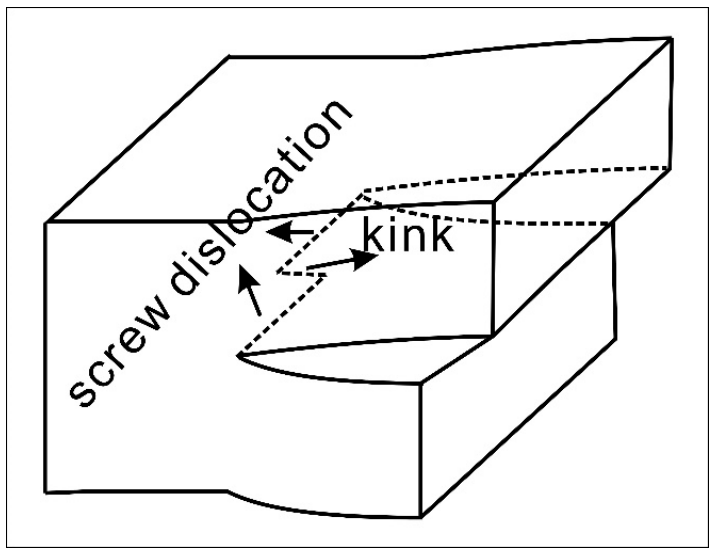
Figure 5. Diagrammatic representation of a kink on a screw dislocation. A kink is a short element of dislocation with the same Burgers vector as the slip plane. It is a deformation mode that is commonly found in crystals with only a slip plane when no extensive glide on the system is geometrically possible and when bending moments are present.